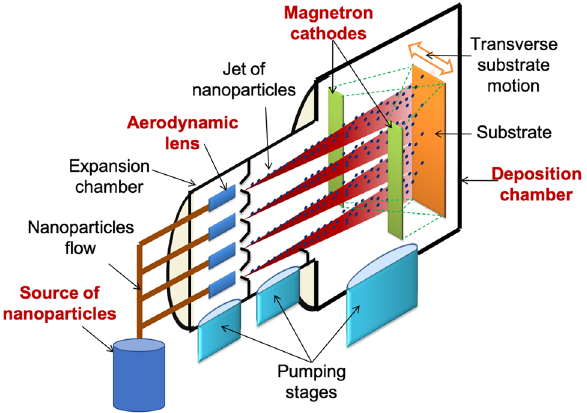
Figure 8. Scheme of a prototype reactor combining a source of nanoparticles, an expansion chamber equipped with four aerodynamic lenses vertically positioned, and a sputtering deposition chamber in which the motion of the substrate-holder is transversal to the nanoparticles.